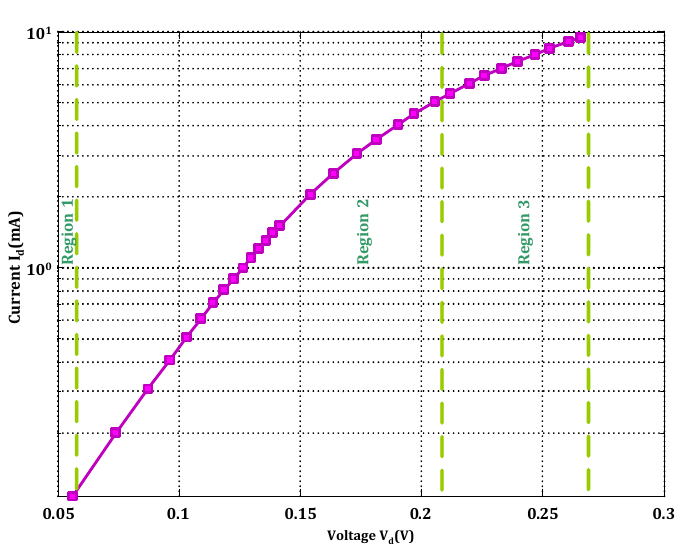
Figure 3. I-V measured current for the ZBD Schottky diode under testing . Table 1. Extracted value of parameters in Equation (1).